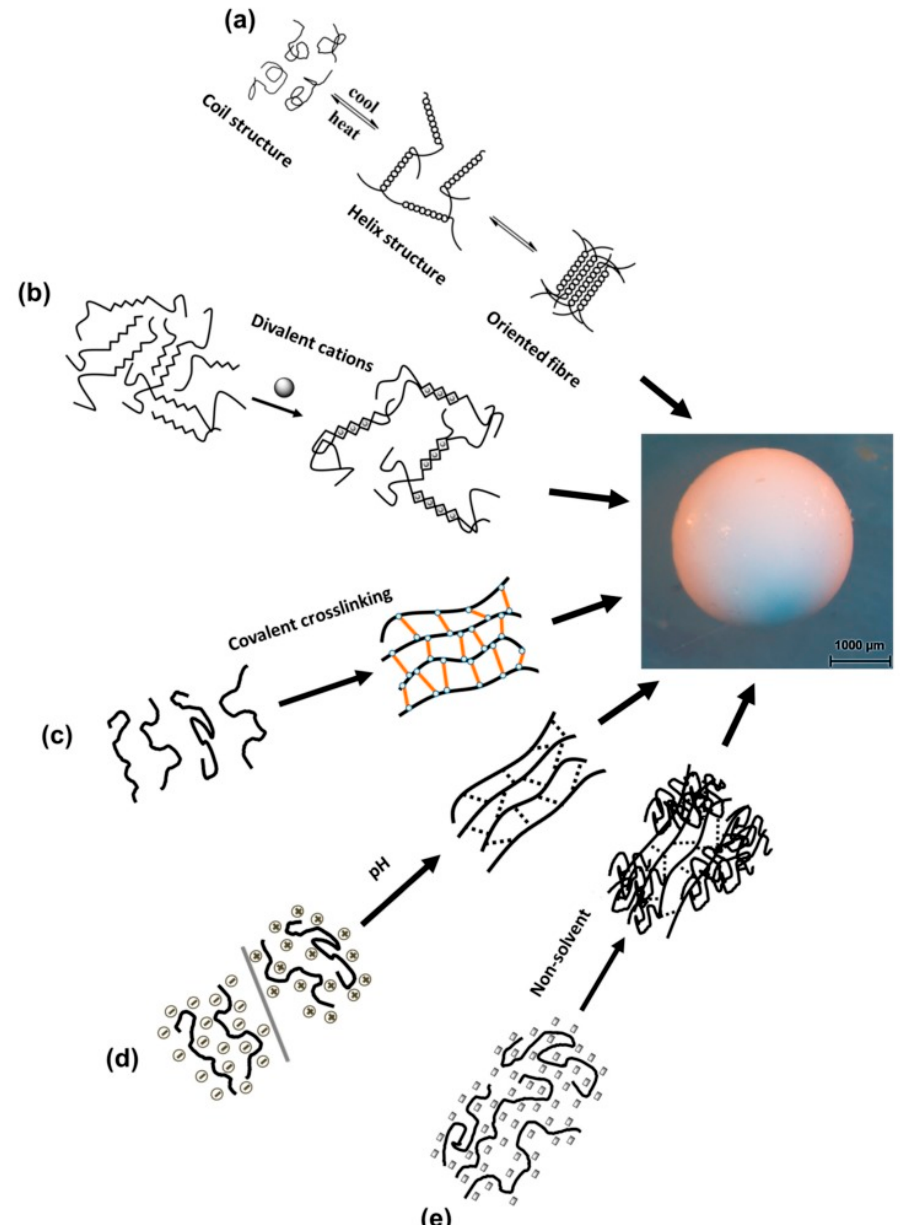
Figure 2. Schematic illustration of the mentioned mechanisms of formation of polymer hydrogel particles: ( a ) temperature-induced (thermotropic) gelation in which the polysaccharides undergo the structural transition from the coil to helix and then to double helix, ( b ) ion-induced (ionotropic) gelation in which the polysaccharide molecules are crosslinked by ions, ( c ) covalent crosslinking approach in which the polysaccharide chains are covalently crosslinked to form gel network, ( d ) pH-induced gelation, and ( e ) non-solvent approach to producing a non-solvent filled gel network [37].